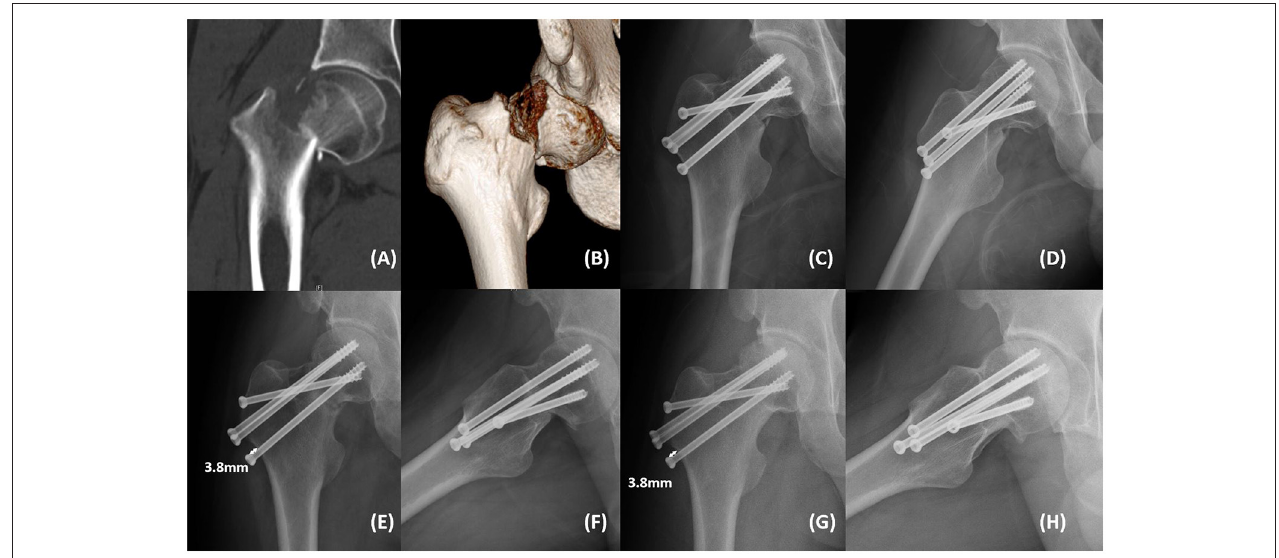
FIGURE 2 | A 28-year-old man from the FCS group presented with right hip pain and limited mobility after a fall. (A,B) Computed tomography showed right femoral neck fracture (Garden IV, Pauwels III). (C,D) Postoperative anteroposterior and lateral radiographs showed satisfactory fracture reduction with acceptable implant position. (E,F) Anteroposterior and lateral radiographs at the 3-month follow-up showed that the fracture line was blurred with femoral neck shortening (3.8mm). (G,H) Anteroposterior and lateral radiographs at the 22-month follow-up showed that the fracture was healed without femoral head collapse and internal fixation failure. The Harris hip score was 97 with mild femoral neck shortening (3.8mm).